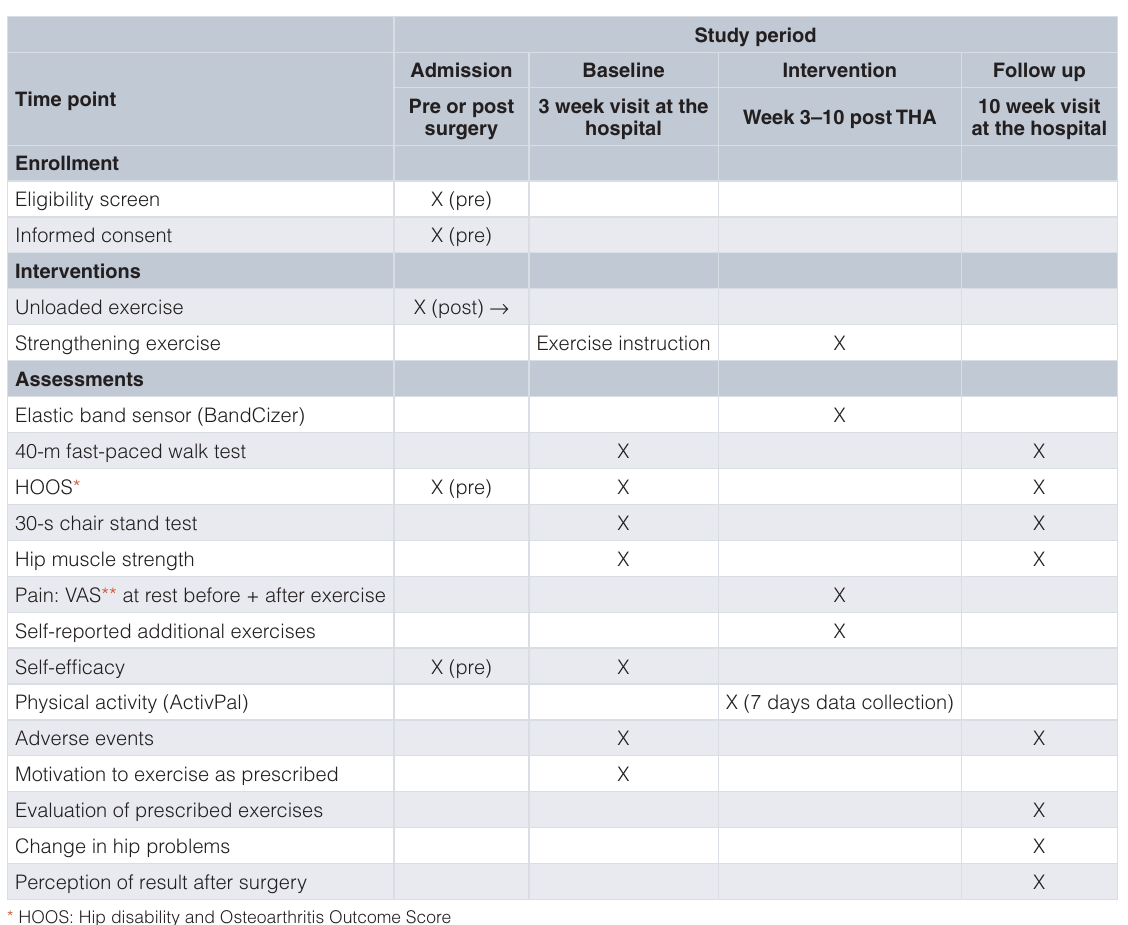
Table 1. Participant